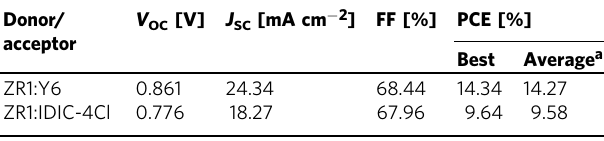
Table 1 Detailed photovoltaic parameters of the OPV